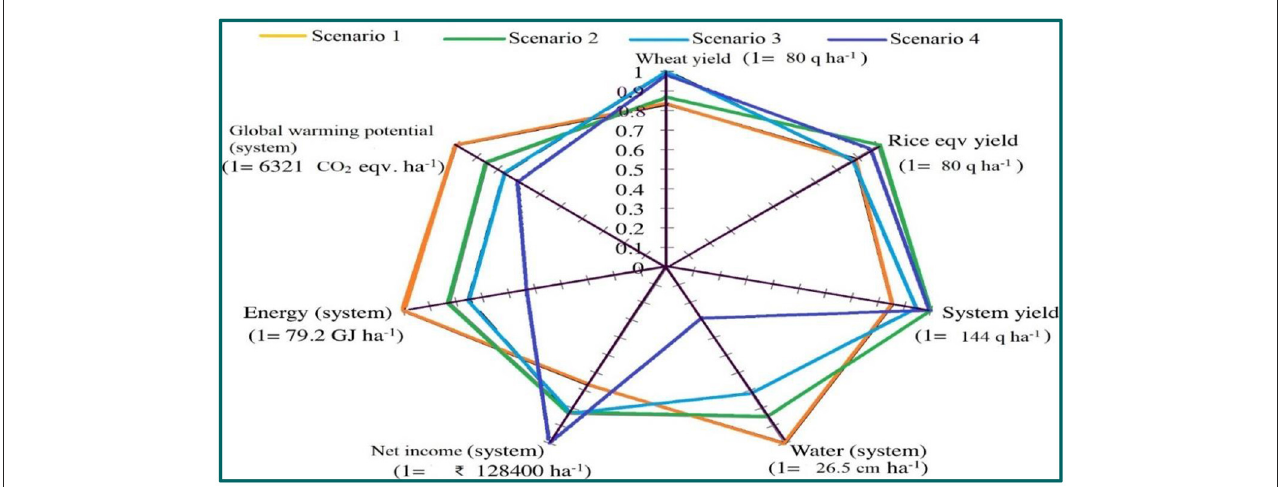
FIGURE7 Several indicators of assessing the long-term performance of diverse scenarios in IGP at Karnal, India. The reduced–till rice–wheat–mung bean system (scenario 2) produced considerably greater system yield (17%), net return (24%) with 17, 15, and 15% fewer energy inputs, irrigation water, and global warming potential (GWP) over conventional rice–wheat–fallow system (scenario 1). By shifting from scenario 2 to CA-based rice–wheat–mung bean system (scenario 3) there was further saving of 9, 15, and 10% energy inputs, irrigation water, and GWP with similar profitability but yield reduction of 8 q ha − 1 . The shifting from scenario 3 to scenario 4 (CA-based maize–wheat–mung bean system) gave 21% more net income than scenarios 2, 3, and 5% more system yield than scenario 3 with 29–35% fewer energy inputs, 59–66% less irrigation water, and 8–18% less GWP than scenario 2 and 3 (Modified; Kumar et al., 2018). Variable means are normalized on a 0–1 scale, where 1 represents the greatest absolute value of that variable. The highest absolute value is also shown for each parameter.